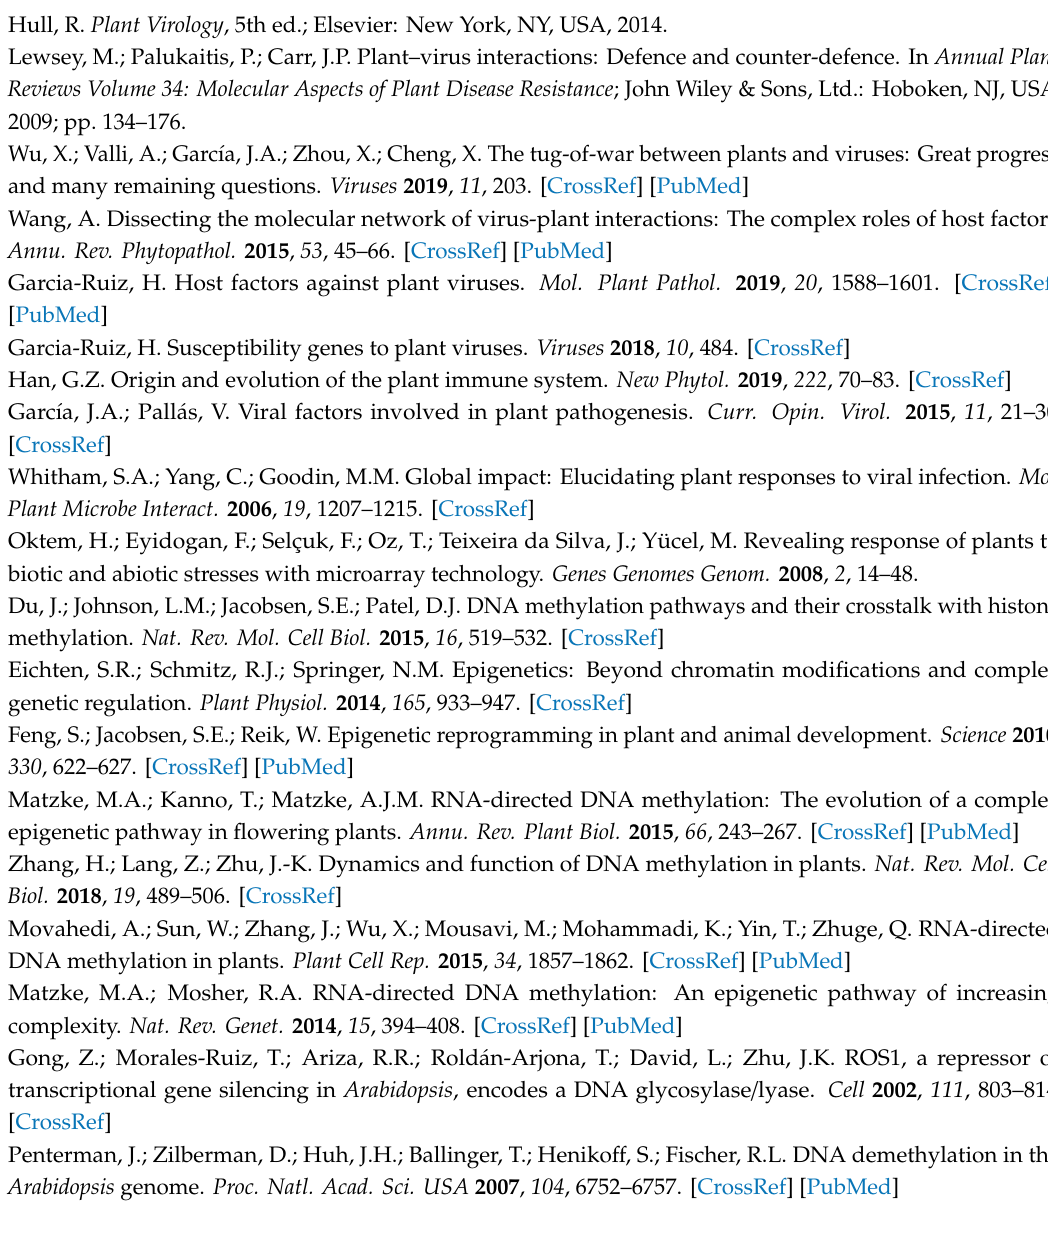
Table S1: List of primers used in this work, Figure S1: Nicotiana benthamiana plants infected with PLPV at 34 d.p.i., Figure S2: Phenotypic alterations in 35S::p37 transgenic plants, Figure S3: Analysis of p37 accumulation in Nicotiana benthamiana leaves agroinfiltrated with pMOG800-p37 or pMOG800, the empty binary vector (as